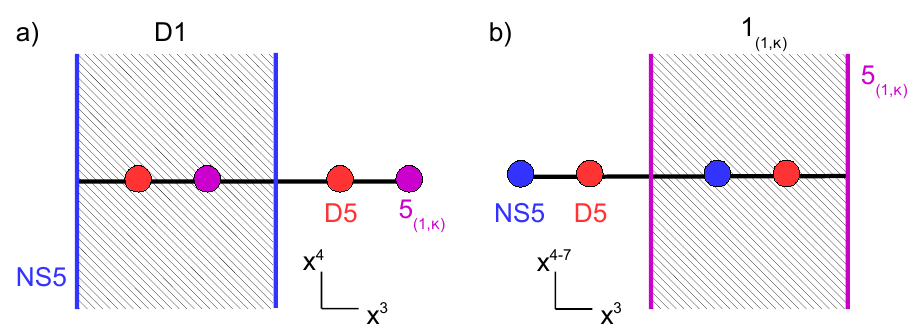
strings, from which we read the relation (a) on (1 ;(cid:20) )